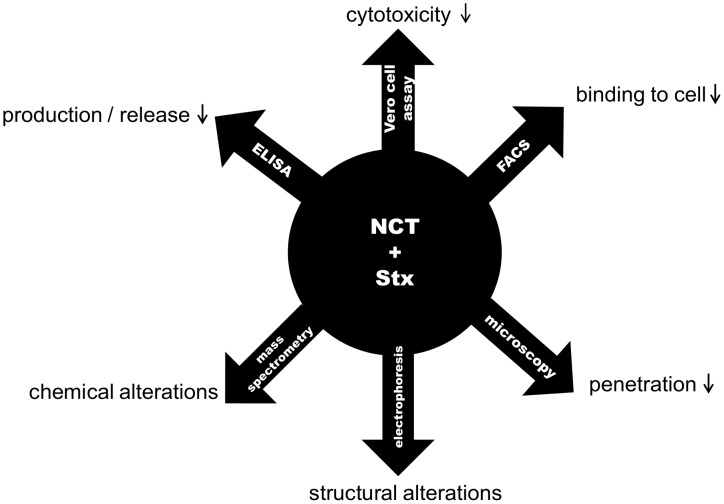
Survey of the impacts of NCT on Stx2.The found effects of NCT on Stx2 are summarized in this figure.